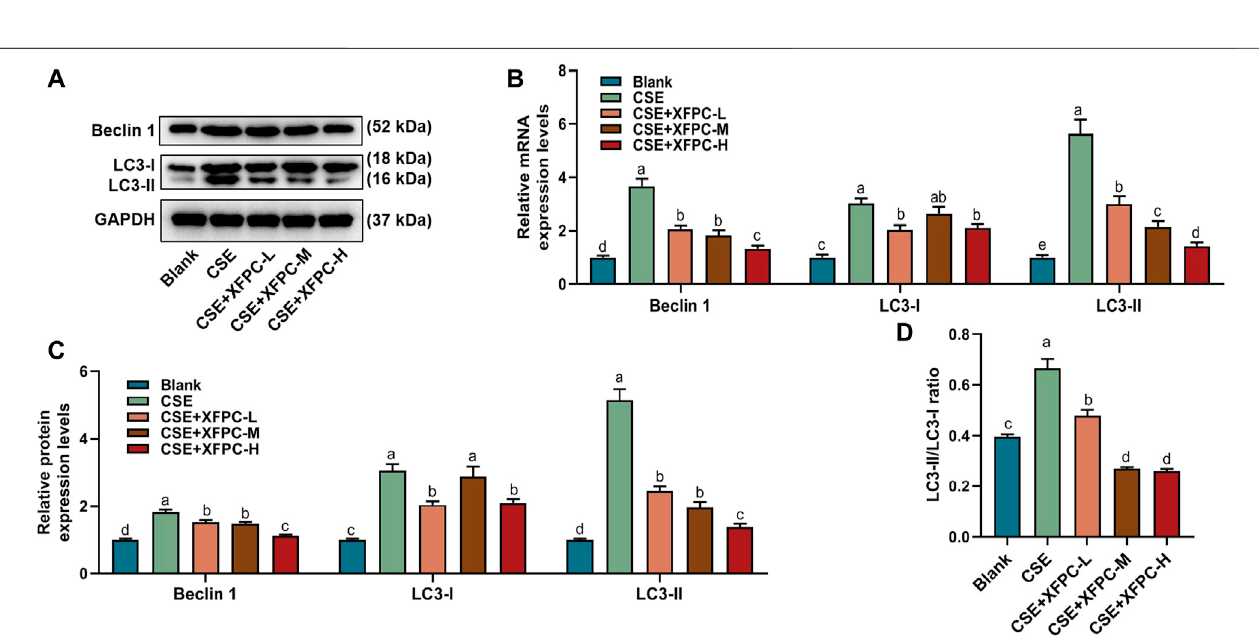
doses of XFPC were used to treat the cells in the model. After treatment, the HBE cells showed an elongated shape after attaching to the wall, and the number of cells increased ( Figure 2A ). The immuno fl uorescence test of LC3-II protein showed that CSE activated autophagy in HBE cells, leading to the accumulation of autophagosomes. XFPC